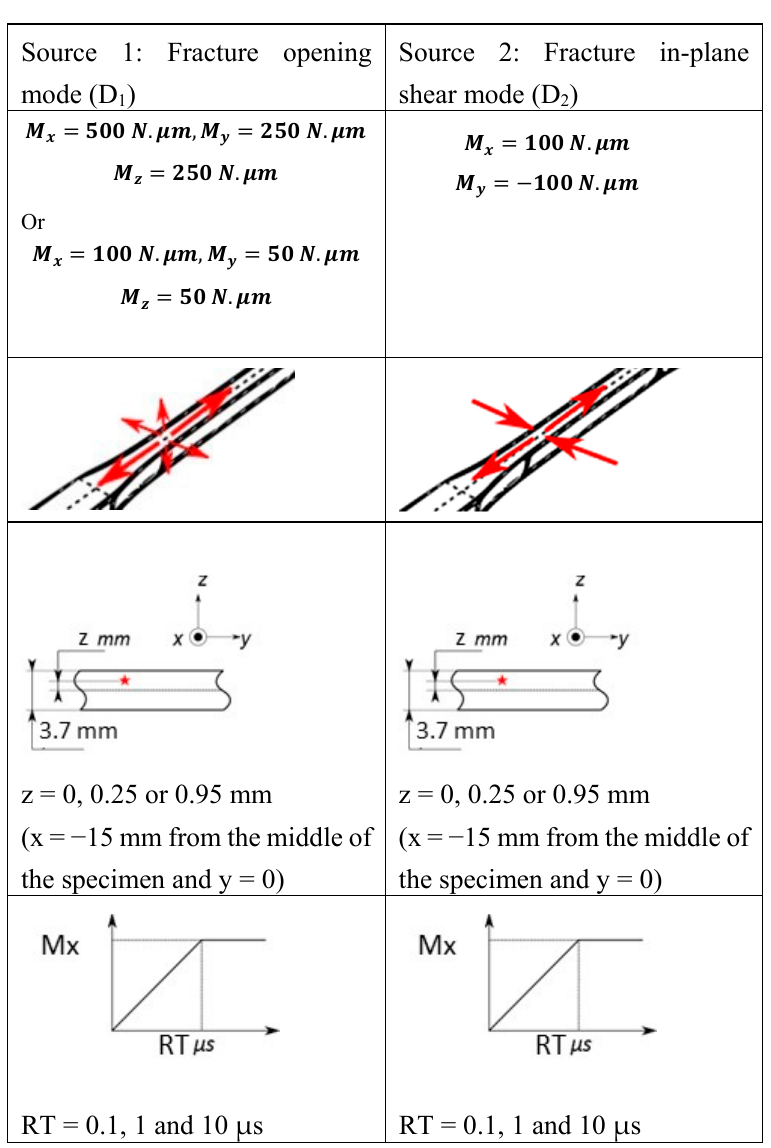
Figure 3. Amplitude of the chirp source in the ( a ) time domain and ( b ) frequency domain.